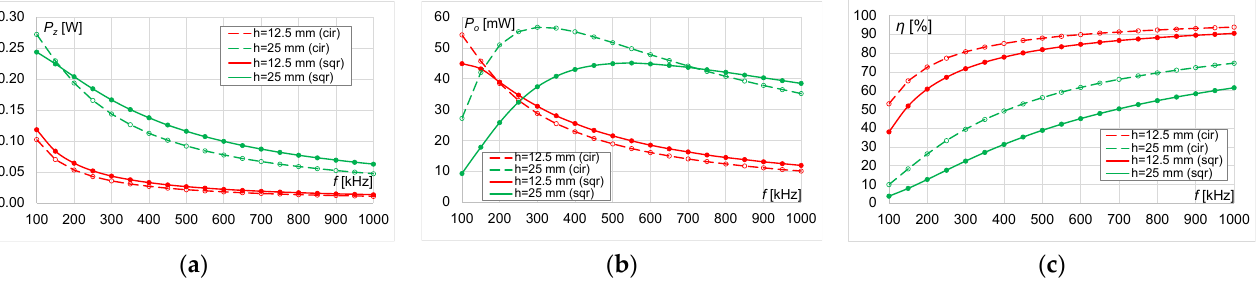
Figure 12. Results for circular and square coils with r = 25 mm and number of turns n = 40 at different distances ( h = 12.5 mm and h = 25 mm): ( a ) transmitter power, ( b ) receiver power and ( c ) power transfer efficiency.